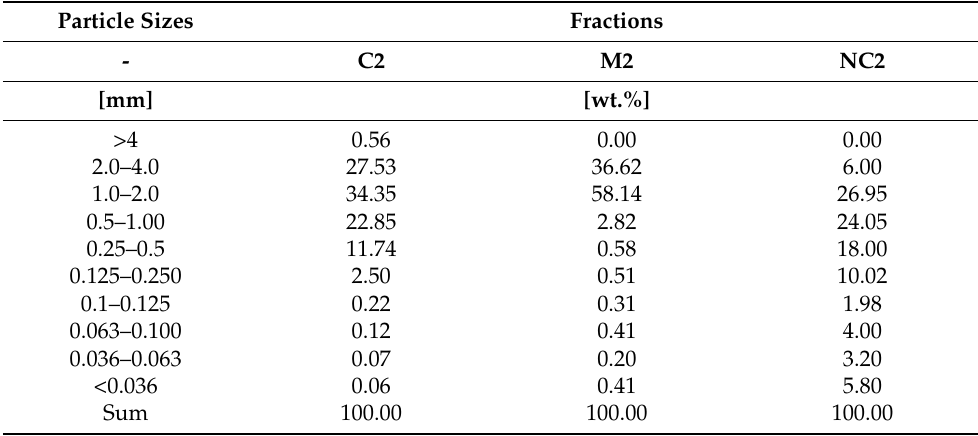
Table 7. Particle sizes distribution of fractions C2, M2, and NC2